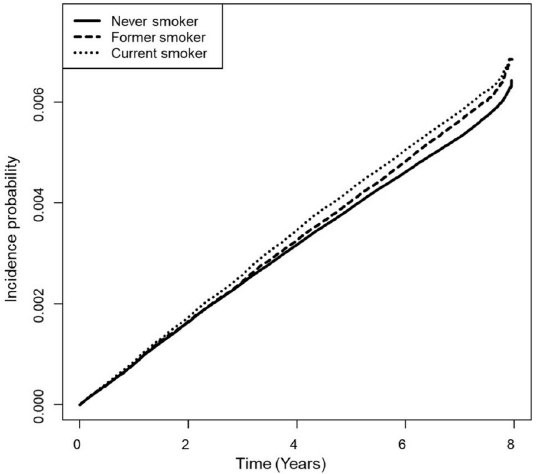
Fig 2. Cumulative incidence curve of tuberculosis according to smoking status by Kaplan-Meier method and log- rank test ( P < 0.0001).